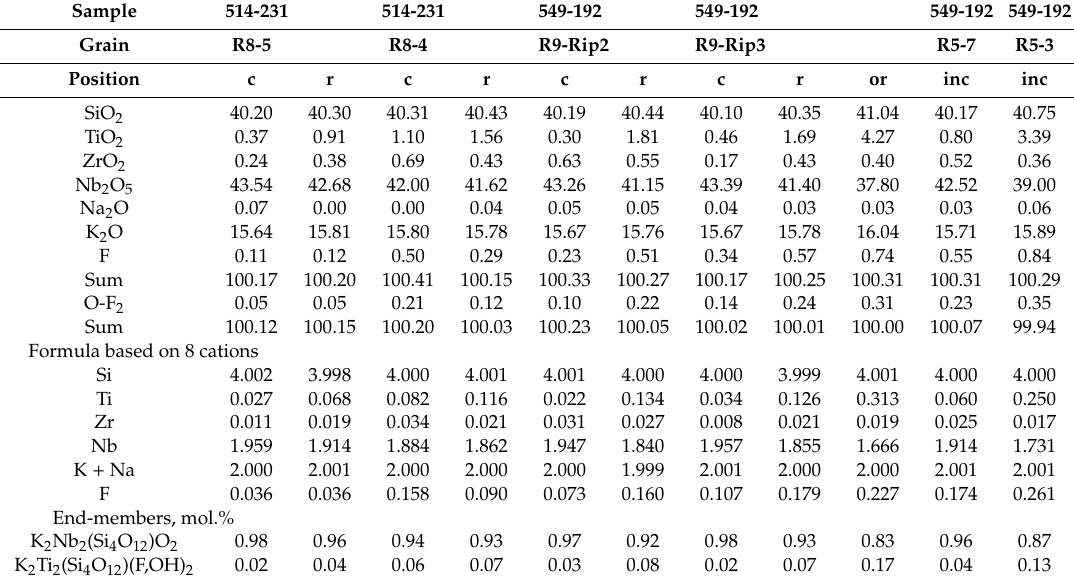
Table 3. Representative compositions (EMPA-WDS, wt %) of rippite from other Chuktukon calciocarbonatites, Chadobets upland, Siberia, Russia.